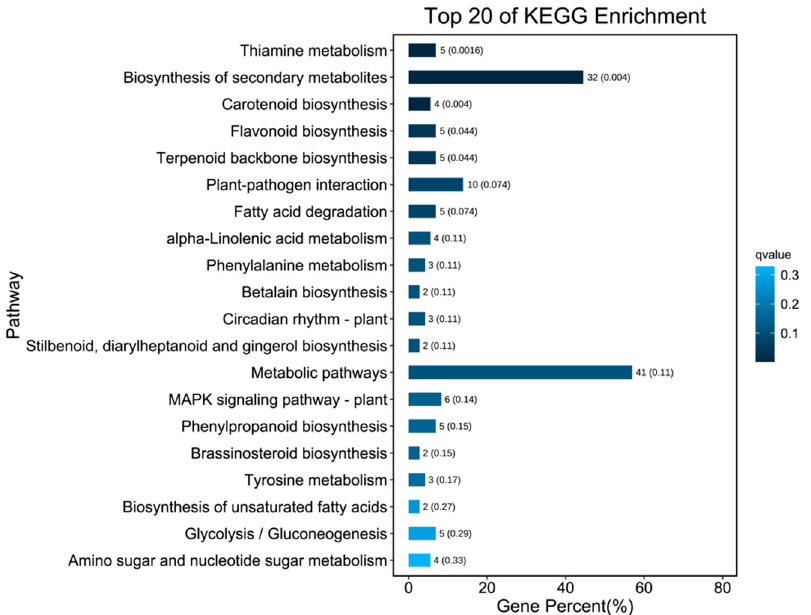
Figure 8. KEGG enrichment bar chart. The first 20 pathways with the lowest Q value are used to draw the map, the ordinate is pathway, the abscissa is the proportion of the pathway number in all differential genes; the darker the color, the smaller the Q value, and the value on the column is the pathway number and Q